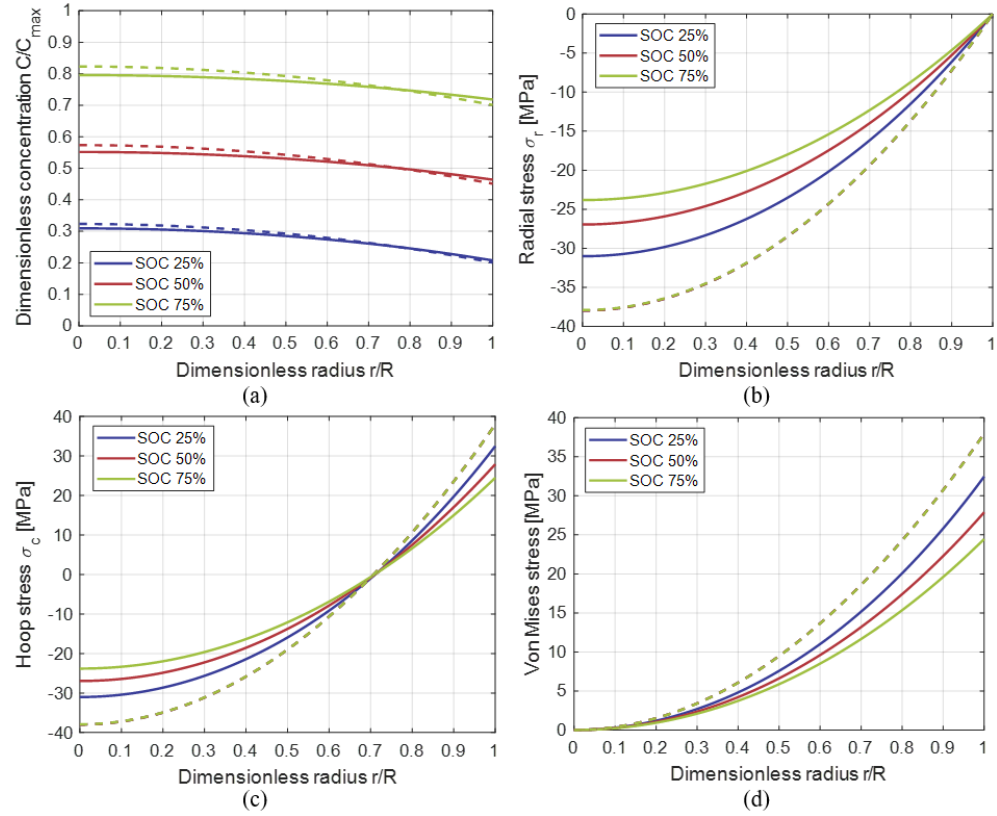
Figure 6. Lithium concentration ( a ), radial stress ( b ), hoop stress ( c ) and Von Mises stress ( d ) for different SOC levels in galvanostatic extraction in anode material. Dashed lines refer to the uncoupled model and solid lines refer to the coupled